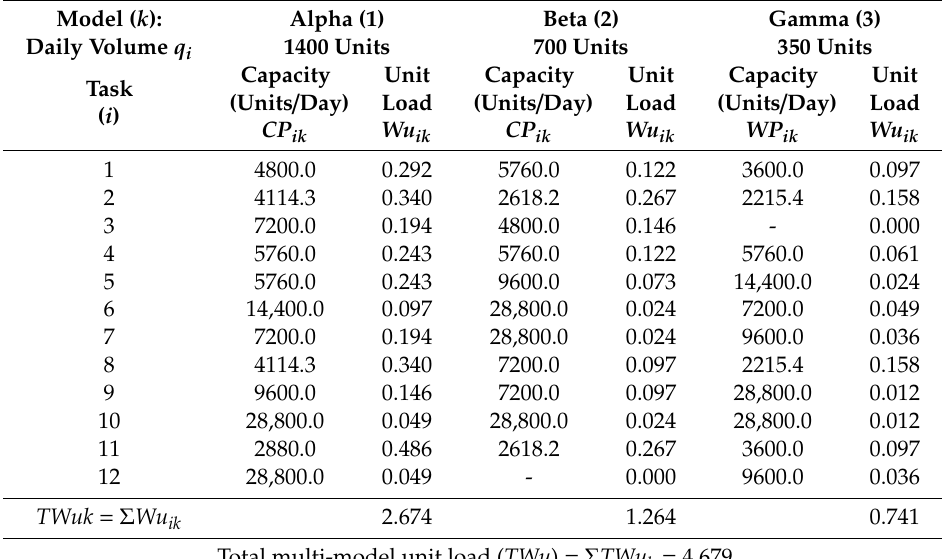
Table 5. Capacity and unit workload for each task and each model.